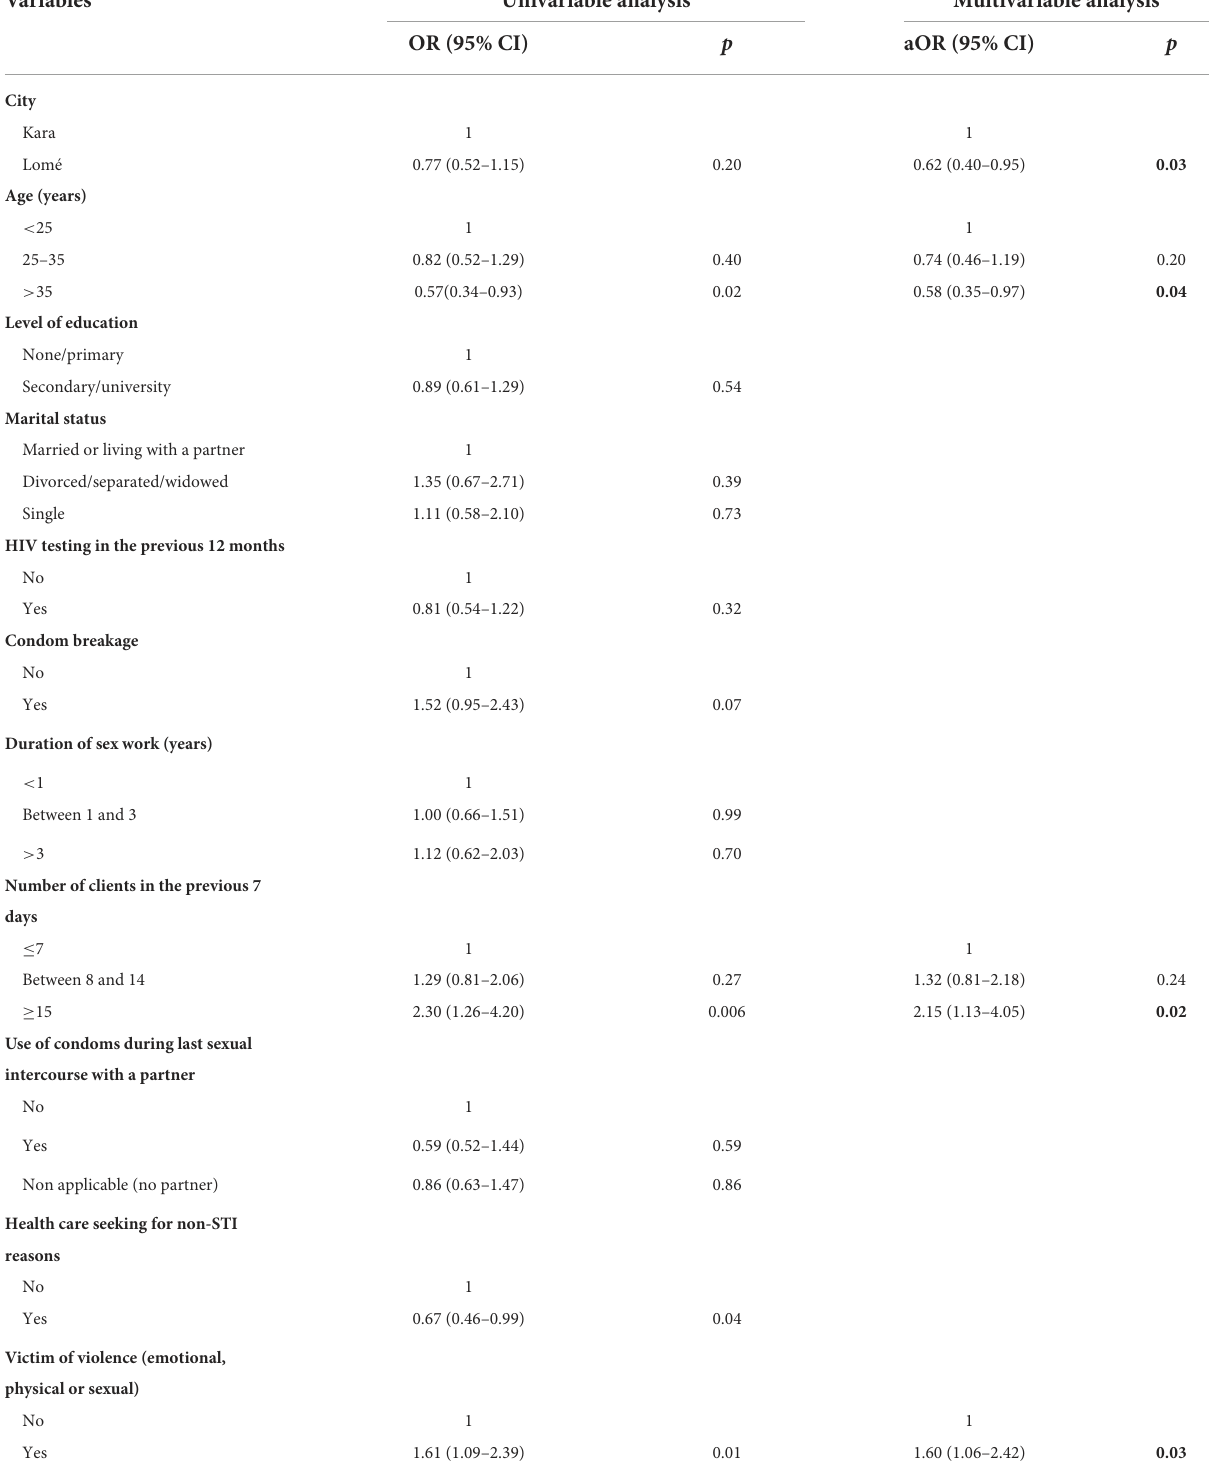
TABLE 3 Factors associated with self-reported STI symptoms during the previous 12 months among FSW in Togo in